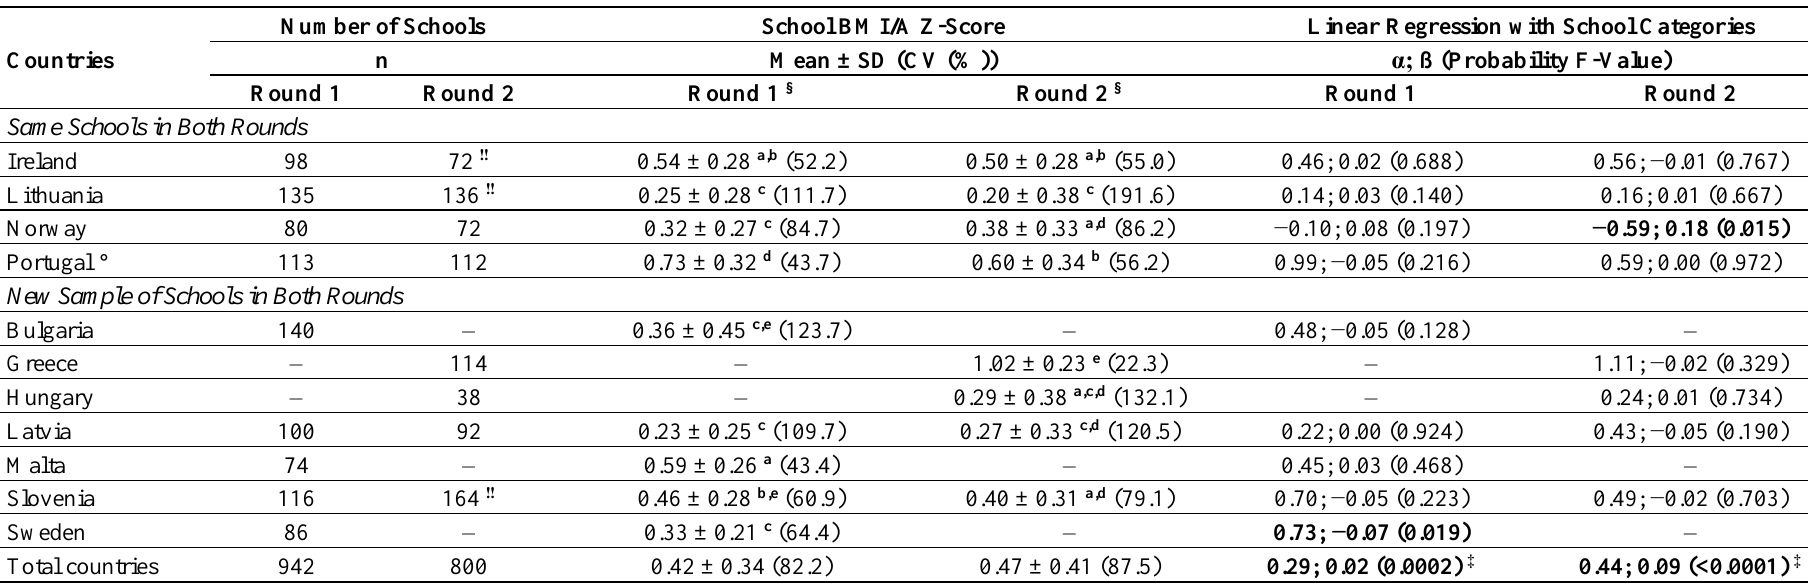
Table 4. School BMI/A Z-score characteristics and linear regression analyses between school BMI/A Z-score and school category based on the number of characteristics graded as supportive * of primary schools † in COSI rounds 1 (2007/2008) and 2 (2009/2010), by sampling approach and